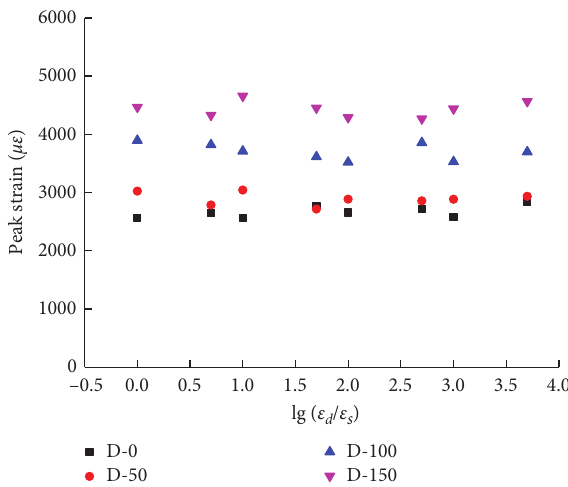
Figure 12: The effect of strain rate on the ultimate strain.